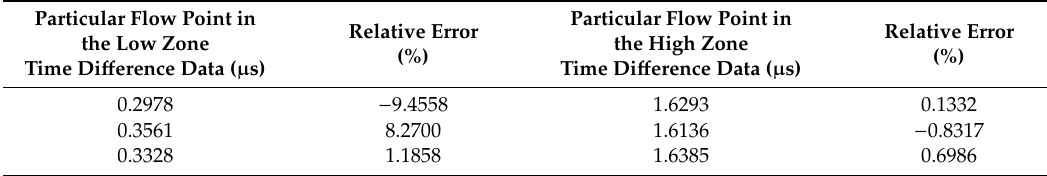
Table 3. Time-difference signal samples without data filtering. Table 3. Time-di ff erence signal samples without data filtering.